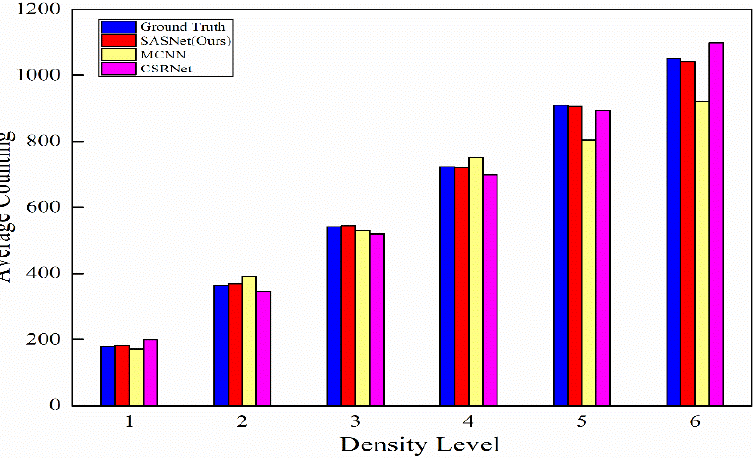
Figure 4. The histogram of average counts estimated by different approaches on six density levels from ShanghaiTech Part_A dataset.